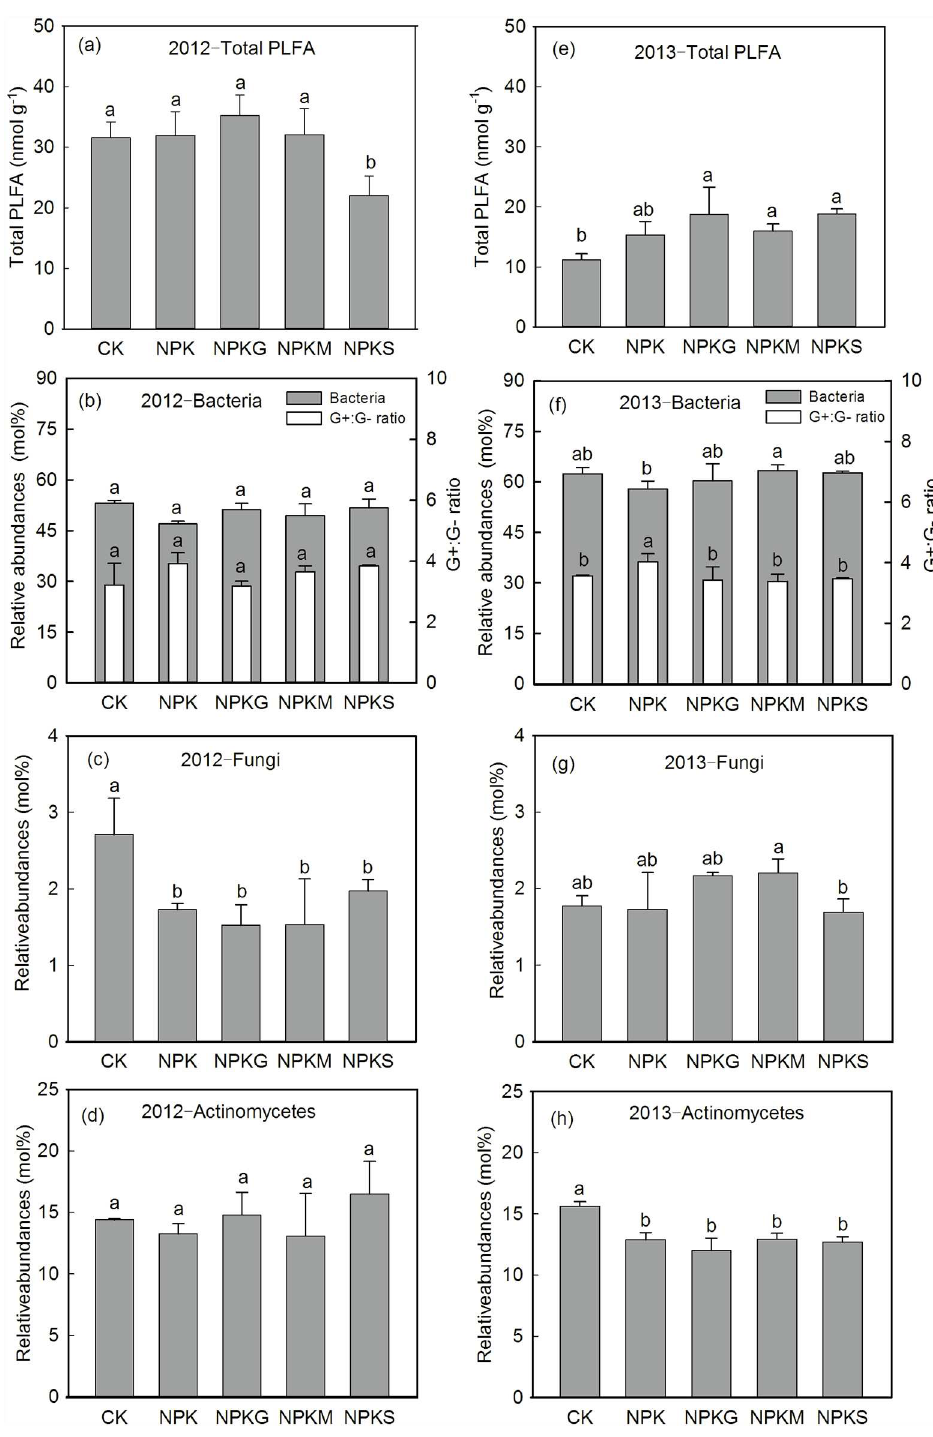
Fig 5. Variations of the total PLFA, relative abundance of bacteria, ratio of gram-positive to gram- negative bacteria, and relative abundances of fungi and actinomycetes under different fertilizations in the late rice season of 2012 and the early rice season of 2013. Vertical bars representthe SE ( n = 3) and different letters abovebars indicate significantdifferences betweenfertilizations at P < 0.05.